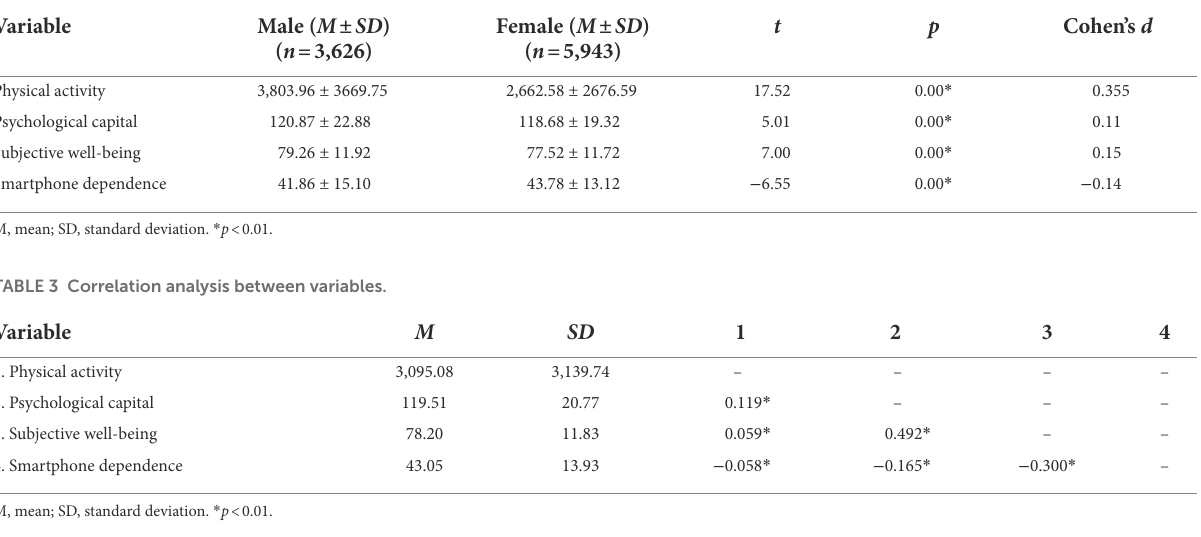
TABLE 2 Mean scores for males and females.